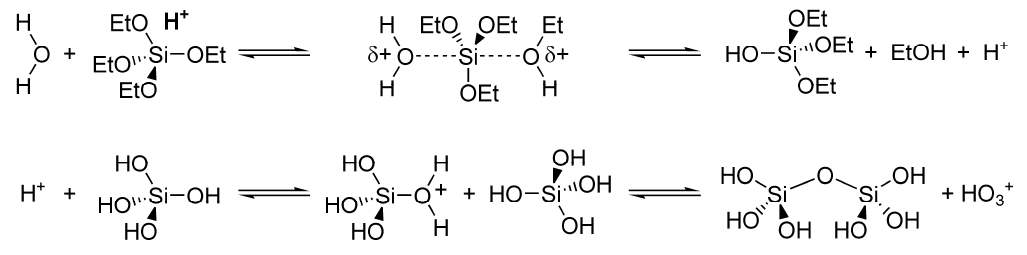
Figure 13. Mechanism of the sol–gel reaction.